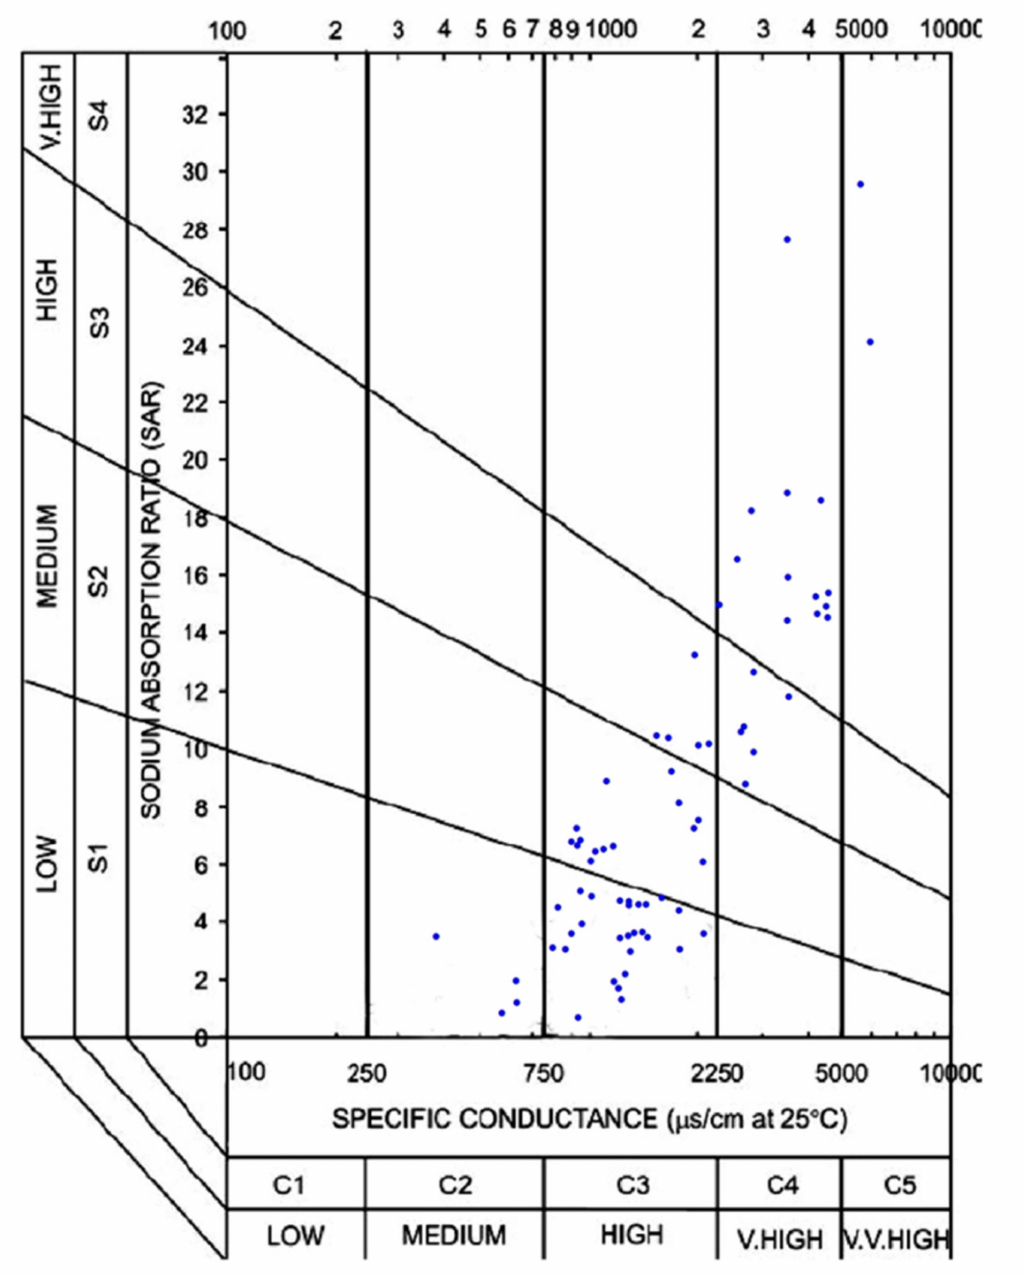
Figure 8. Wilcox (1955) classification of groundwater for irrigation. Blue dots are the groundwater samples. ArcGIS IDW was used to create a surface map of SAR values (Figure 9). Wilcox threshold was used to classify the SAR map into four classes: normal (1.5–10) green color, moderate (11–18) yellow color, high (19–26) brown, and very-high (27–32) light pink color (Figure 9). Spatial analysis of SAR surface map indicated that most of the water wells eastern of the Cairo–Alexandria highway are in the normal class with SAR < 10. The water wells westward of the Cairo–Alexandria highway are included in the medium, high and very-high classes (Figure